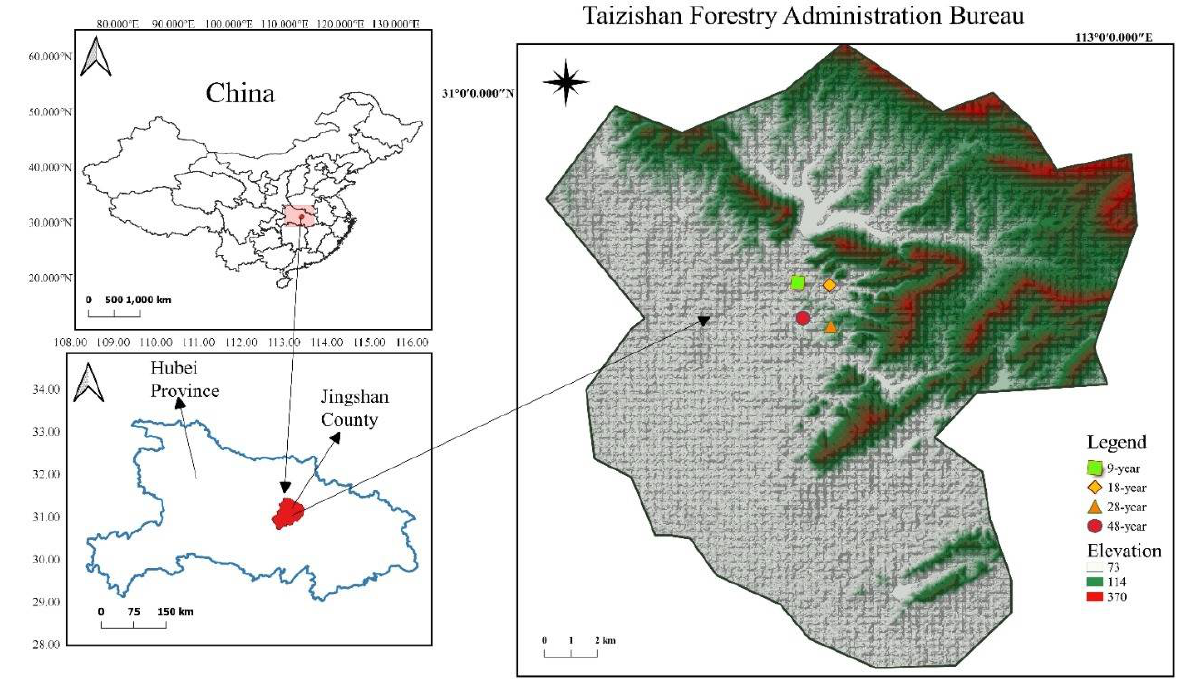
Figure 1. Study area location in the Jingshan County, Hubei province, central China. Different shapes represent different stand age groups of P. massoniana .